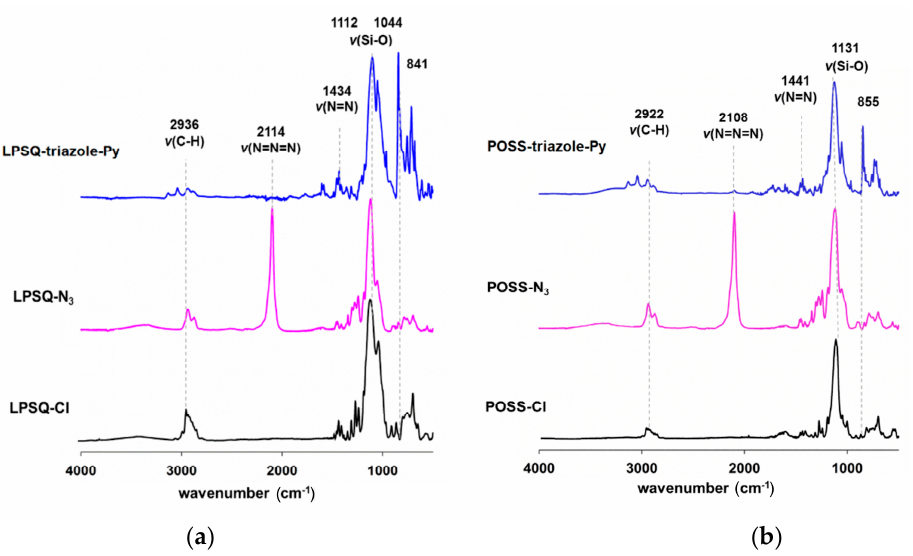
Figure 1. FTIR spectra plotted in absorbance mode (arbitrary units) of ( a ) LPSQ-triazole-Py and ( b ) POSS-triazole-Py along with spectra of the intermediate products.